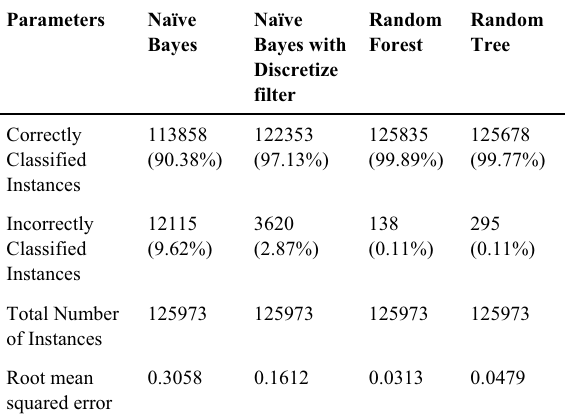
Table 1. Performance of AI classifiers (Cross Validation of 10 Cross Folds)